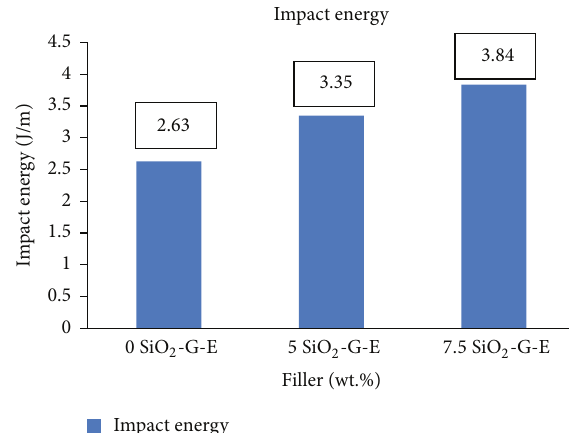
Figure 7: Impact strength of SiO 2 filled G-E